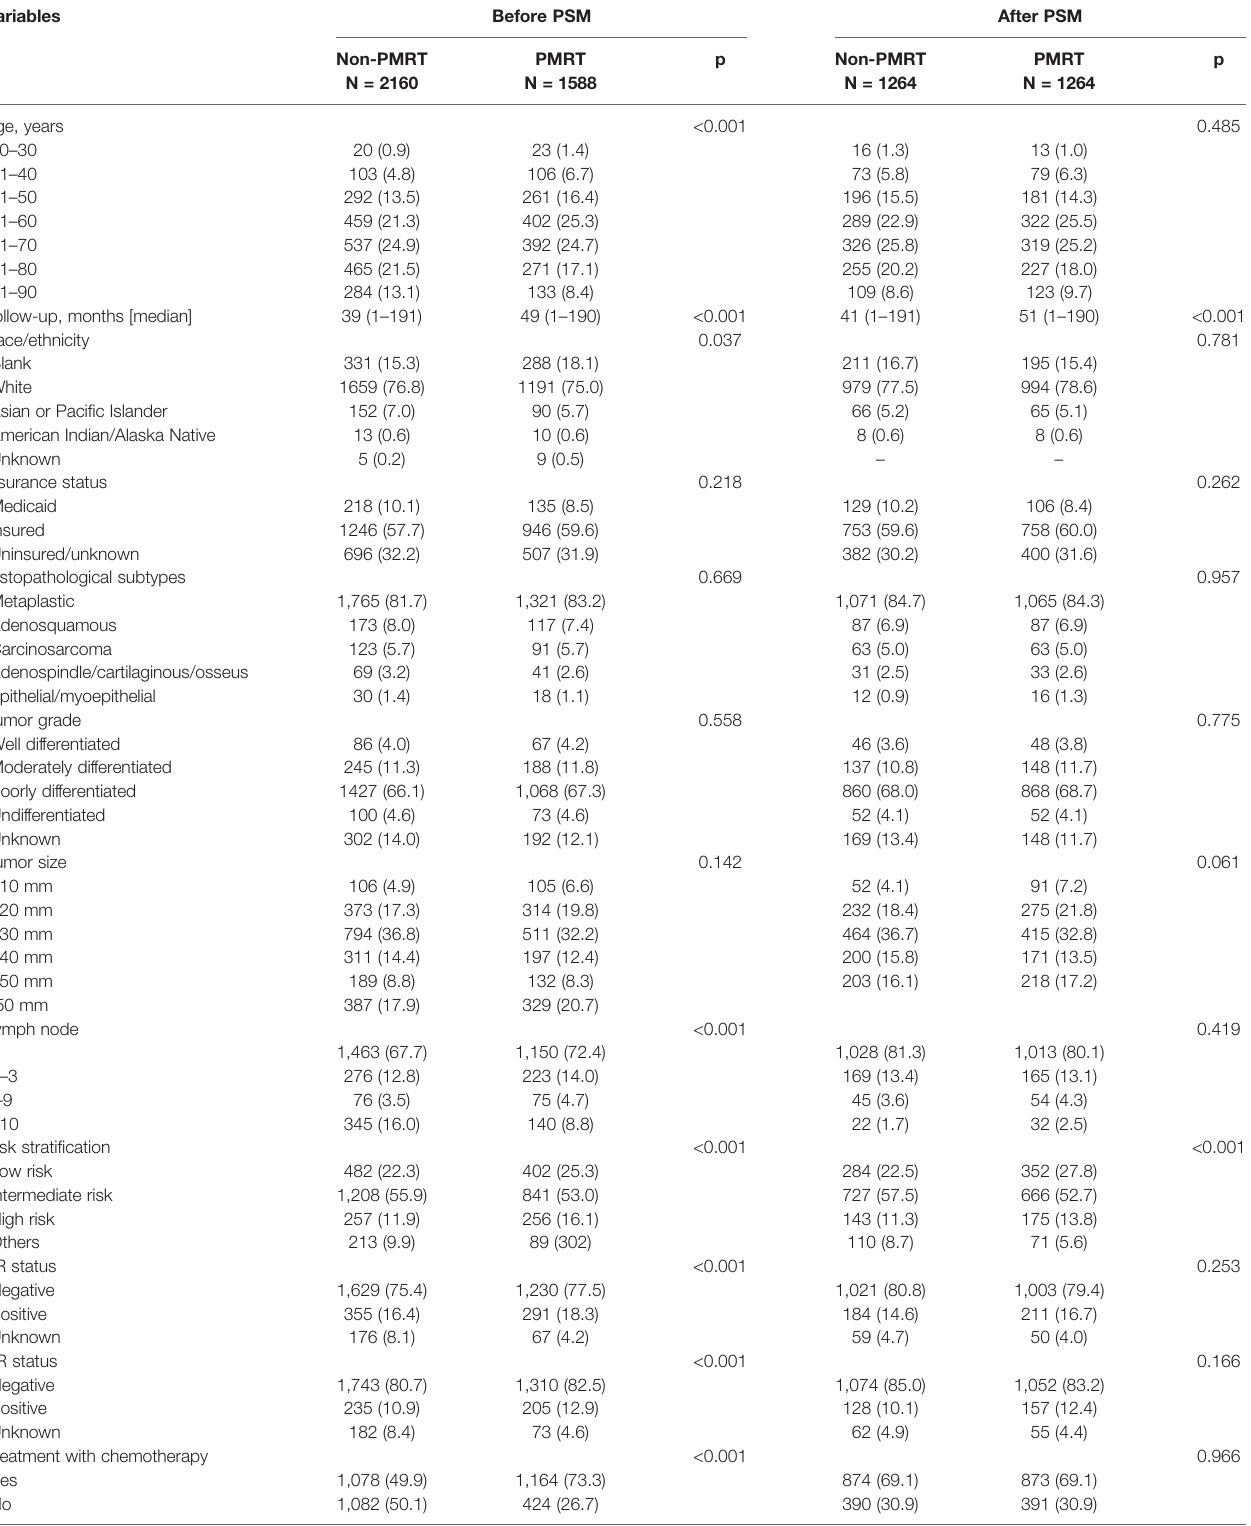
TABLE 2 | Patient demographic and clinical